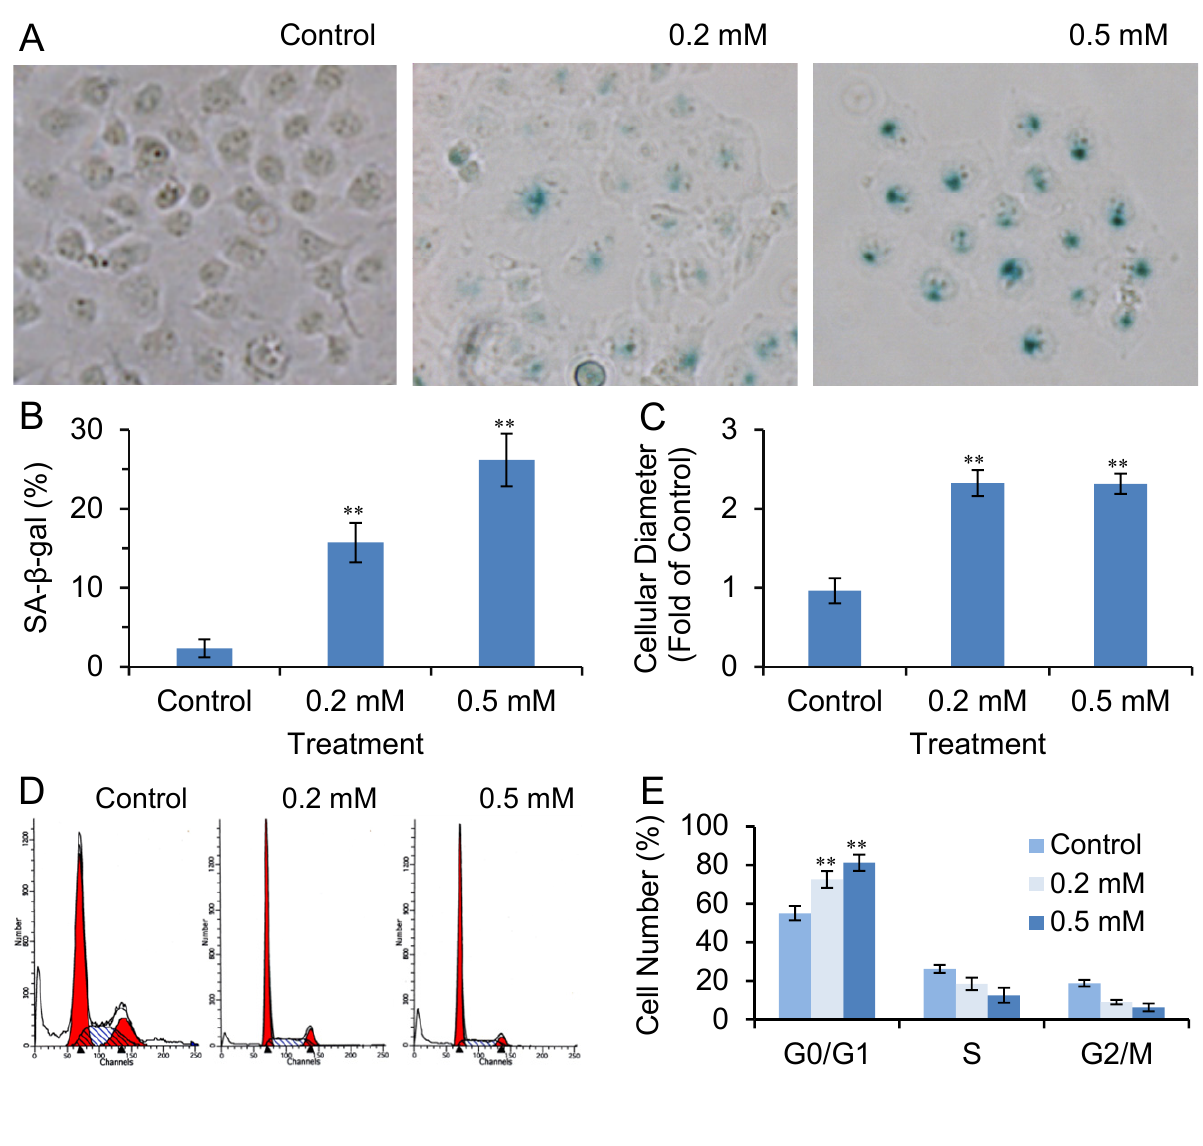
Figure 6. SVP induced cell senescence in Bel-7404 cells. Bel-7404 cells were treated with 0.2 and 0.5 mM SVP for 120 h, and subjected to SA- β -gal staining ( A , ×100) and flow cytometric analysis ( D ). ( B ) SA- β -gal-positive cells were counted and expressed as mean ± S.D. ( C ) Diameter of SA- β -gal positive cells were measured and expressed as fold of control negative cells. ( E ) Cell cycle distribution are expressed as mean ± S.D. Data illustrated are representative of three independent experiments. ** p < 0.01, versus control